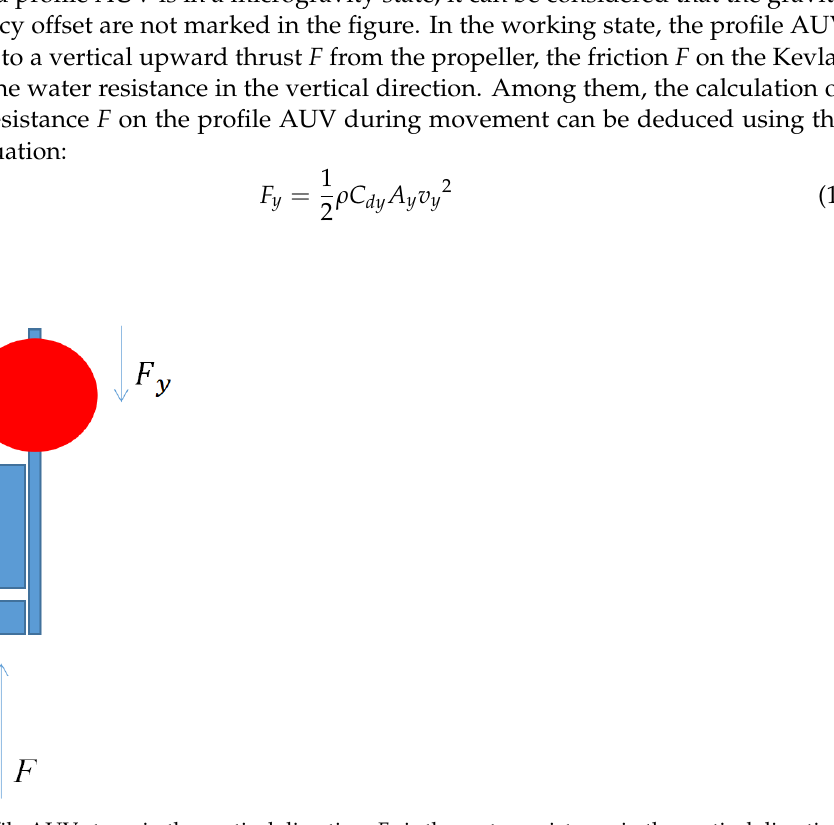
Figure 8. Profile AUV stress in the vertical direction, F y is the water resistance in the vertical direction, f is friction force, F is the propeller